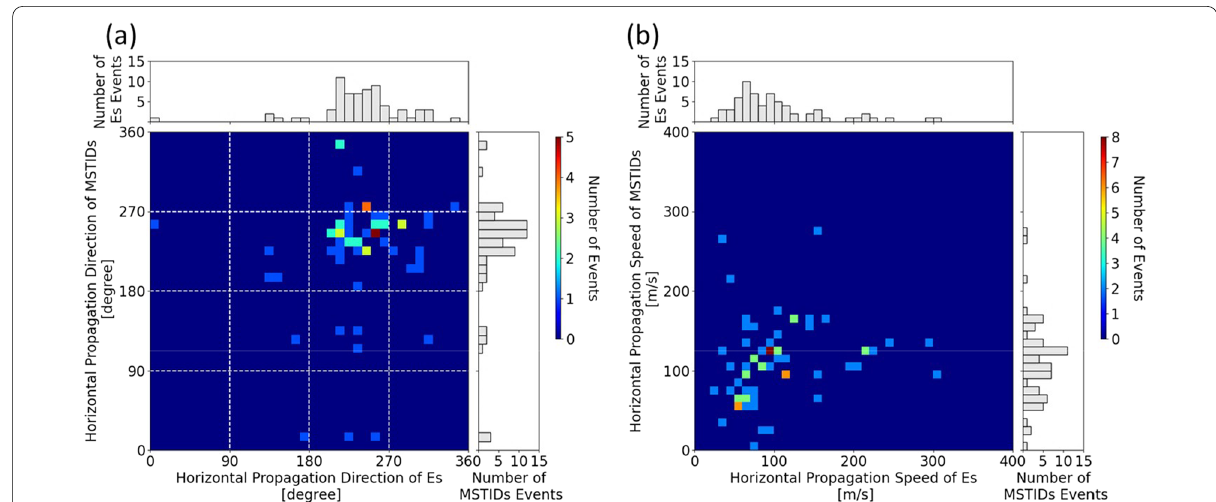
Fig. 6 The propagation parameters of Es and MSTIDs derived by using data from corresponding E and F region data points. The format of the plots is the same as the ones in Fig. 5. Total number of samples was 68. a Propagation directions of Es and MSTIDs in 2014–2017. b Speeds of Es